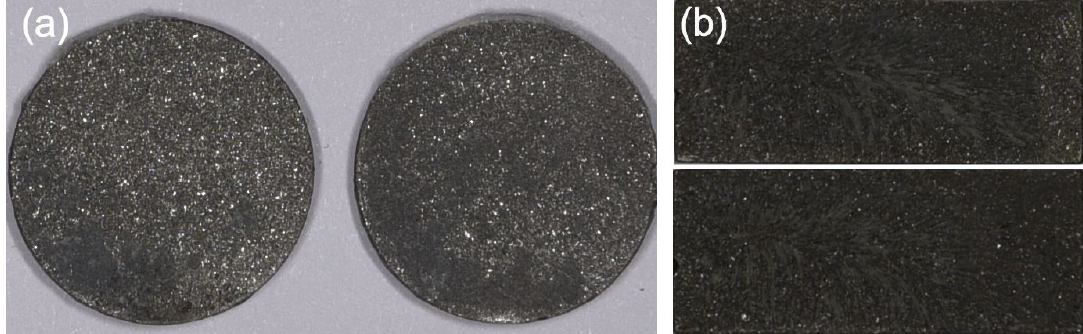
Figure 5. Failure of the tested joints: ( a ) upper element disc ‐ shaped; ( b ) upper element cuboid.